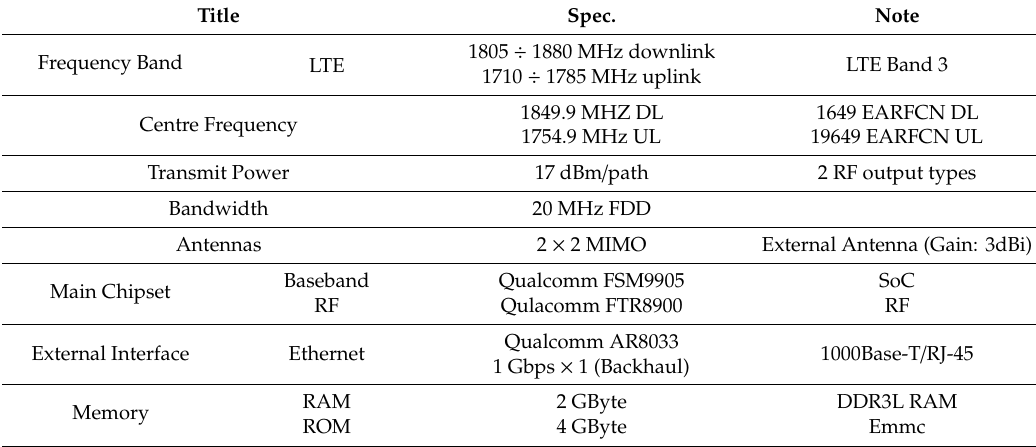
Table 1. LTE Femto AP–General H/W specification.